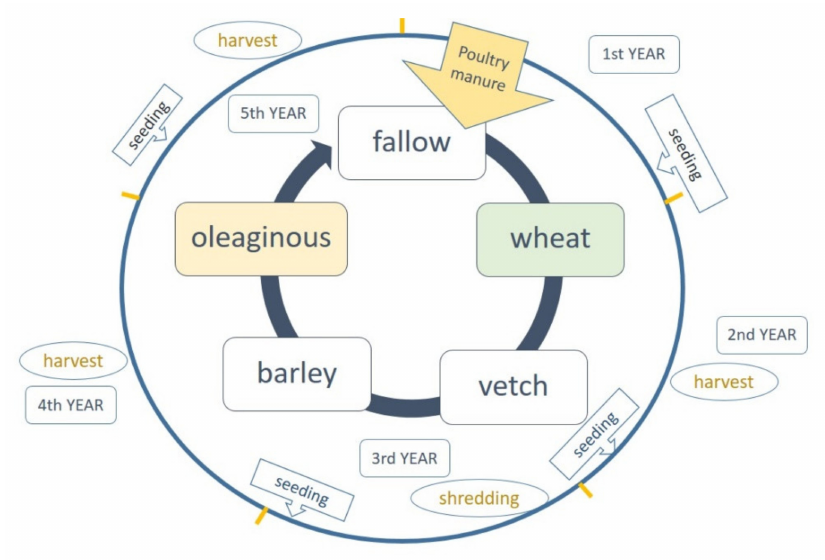
Figure 1. Schematic agronomic calendar, manure application, seeding and harvesting of the crops in the rotation of the ORG treatment. Table 2. Main nutrient contents of the horse manure and the poultry litter: Organic Matter (OM, %), Organic Carbon (OC, %), Kjeldahl N (N, %), Phosphorous (P, g kg − 1 ), Potassium (K, g kg − 1 ) and Calcium (Ca, g kg − 1